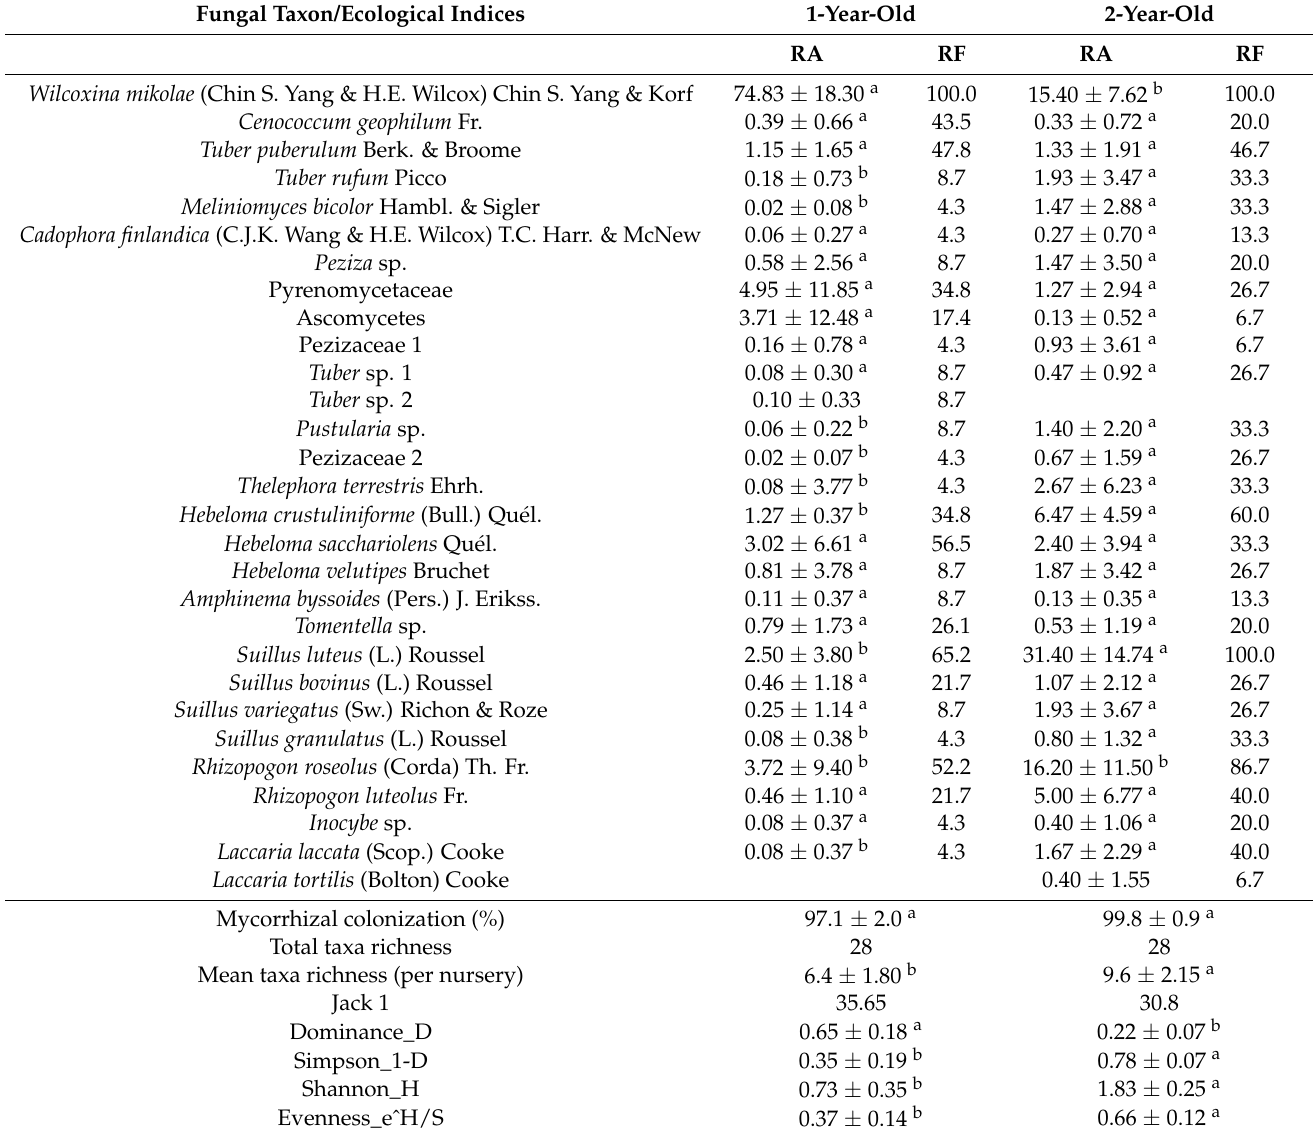
Table 2. Relative abundance (RA), relative frequency (RF), taxa richness, dominance, diversity, and evenness indices of ectomycorrhizal fungal taxa and ectomycorrhizal fungal communities associated with 1- and 2-year-old Scots pine ( Pinus sylvestris L.) seedlings in forests bare-root